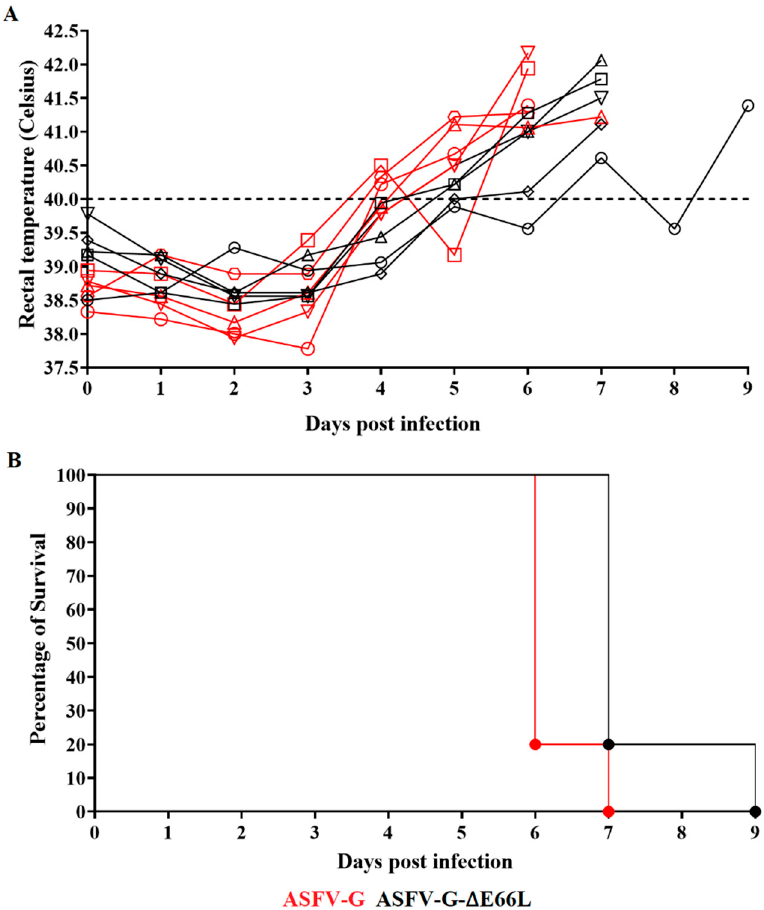
Figure 4. Evolution of body temperature ( A ) and lethality ( B ) in animals (5 animals/group) IM infected with 10 2 HAD 50 of either ASFV-G- ∆ E66L or parental ASFV-G. No statistical differences were found in body temperatures between pigs in both groups when evaluated by the two-stage set-up (Benjamini, Krieger, and Yekutieli) method. Conversely, significant differences ( p -value = 0.0201) in the survival course between groups of pigs were found using the log-rank test (Mantel–Cox test).